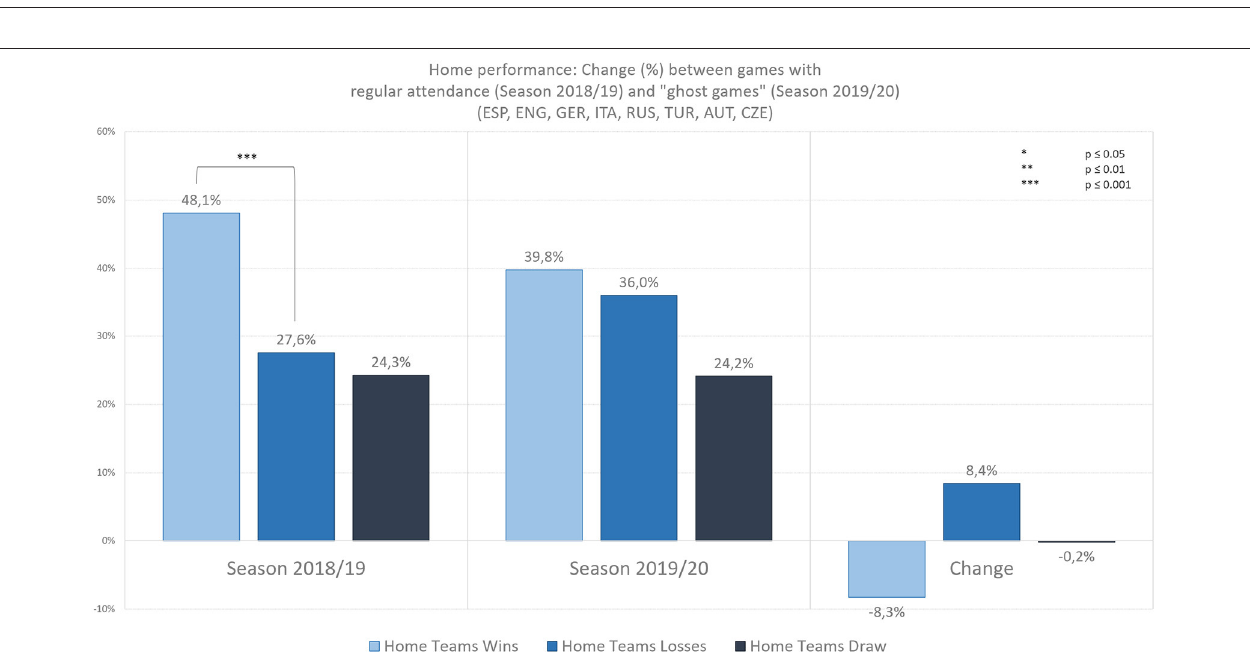
FIGURE 2 | Relative changes of home performance in games with regular attendance (season 2018/19) and ghost games (season 2019/20) in the highest football leagues of Spain, England, Germany, Italy, Russia, Turkey, Austria, and Czech Republic.